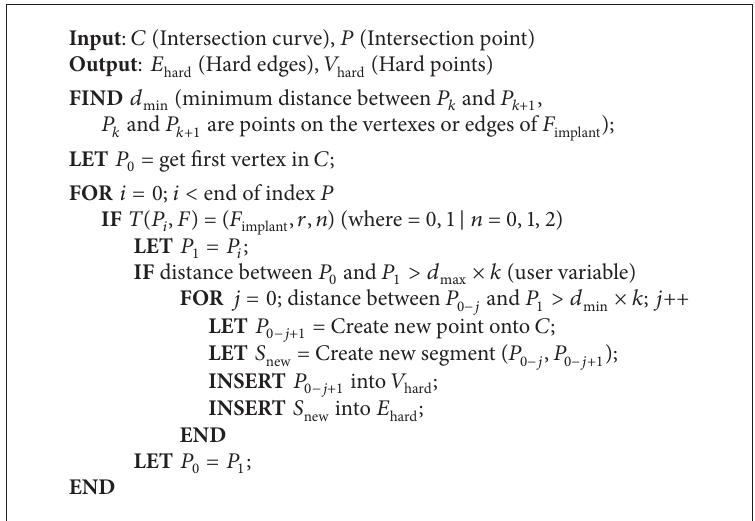
Algorithm 2: Node generation algorithm on the intersection curve to prevent the change of implant model.